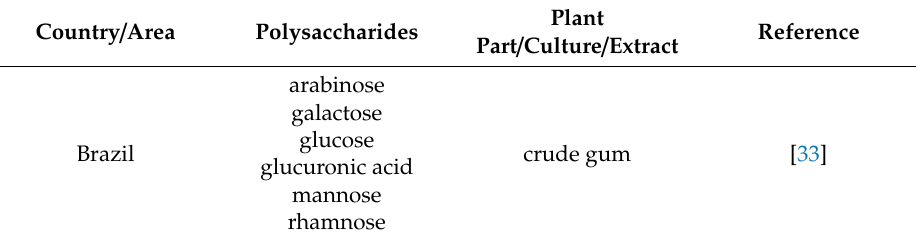
Table 5. Polysaccharides present in Anacardium occidentale.